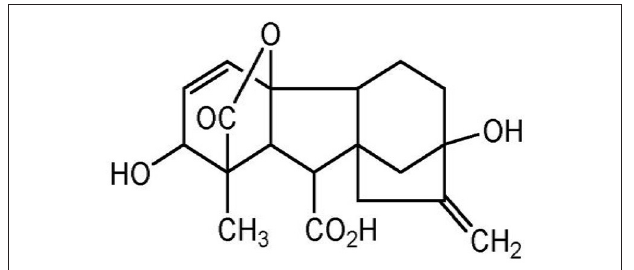
FIGURE 2 | Chemical structure of GA 3 .